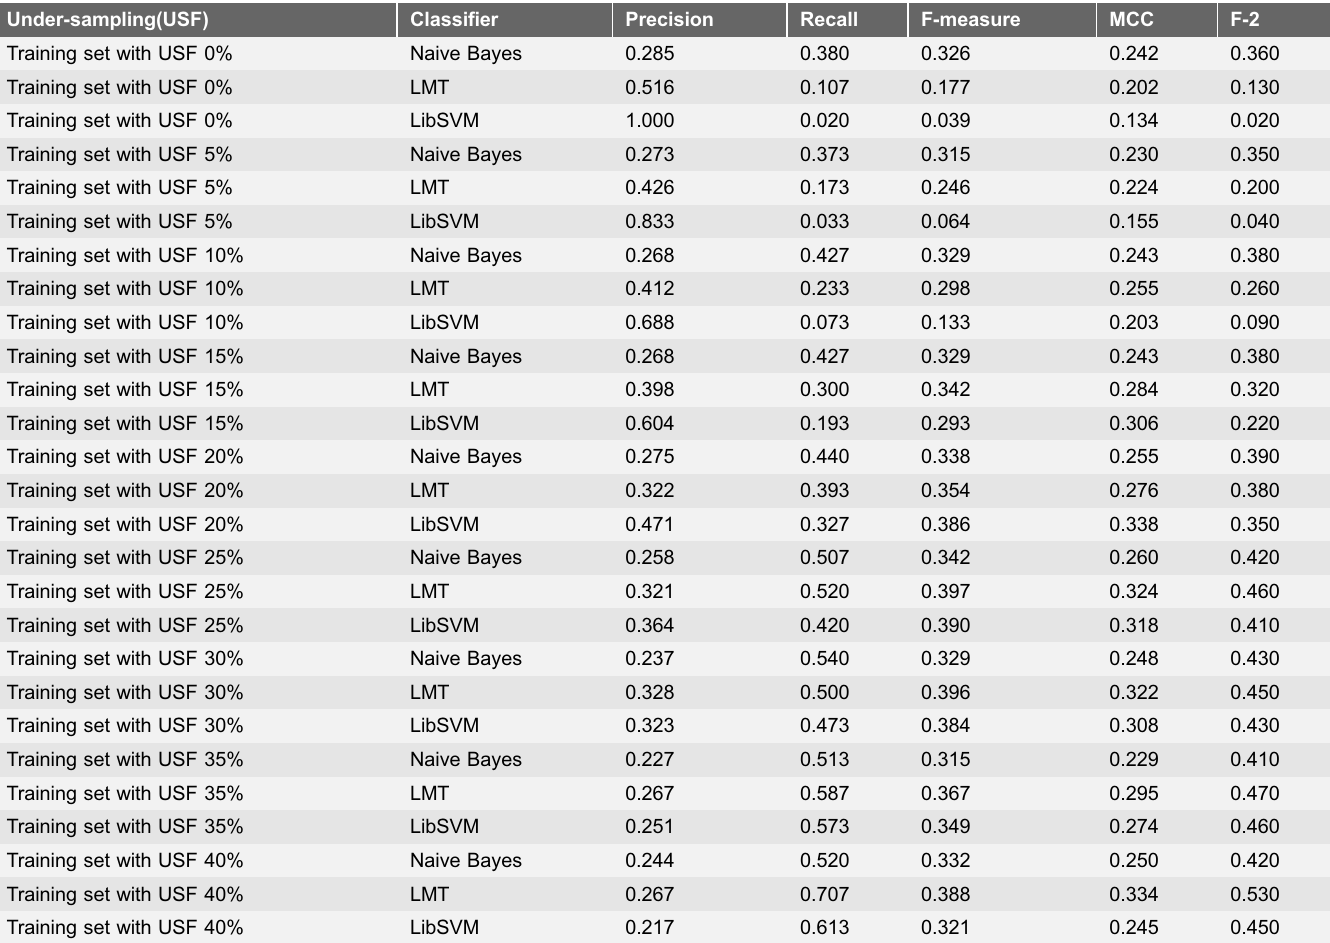
Table 6. mycoSORT Results - Set of Features F1 +